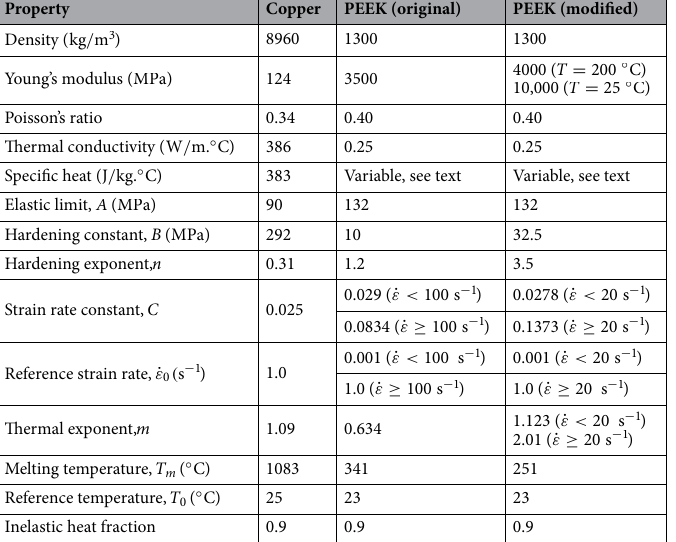
Table 2. Physical and mechanical constants of copper and